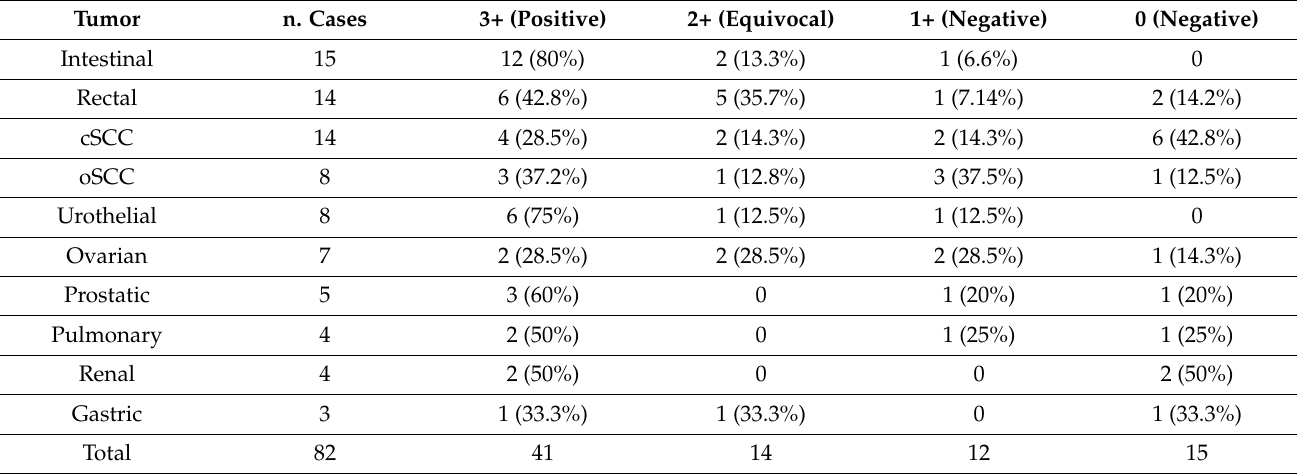
Table 1. HER2 expression in canine carcinomas based on location and positivity score. Tumor n.